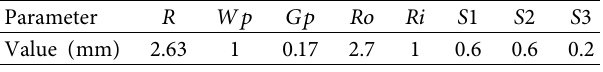
Table 1: Parameters of the proposed radiating element. Parameter